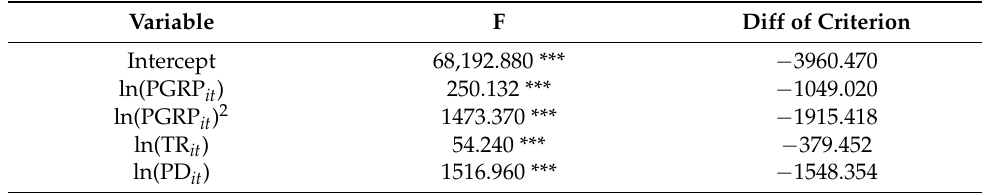
Table 3. Spatial Variability Test.